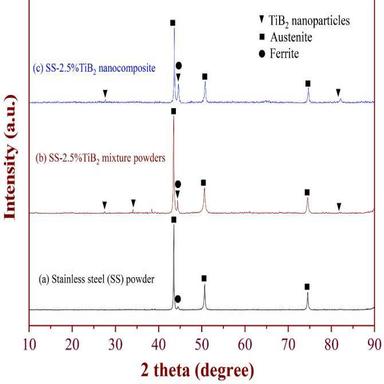
XRD profiles of (a) stainless steel powders, (b) stainless-steel and 2.5 vol % of TiB2 nanoparticles mixture powders, and (c) bulk stainless steelnanocomposite doped with 2.5 vol% of TiB2 nanoparticles.